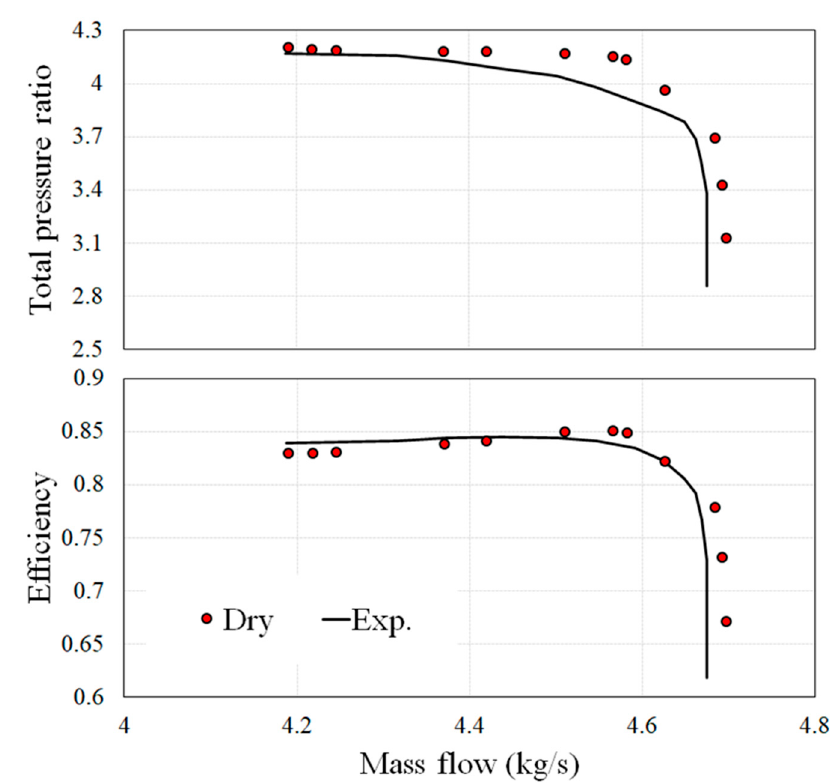
Figure 4. Comparison results of the total pressure ratio and efficiency between the CFD and experi- mental results.